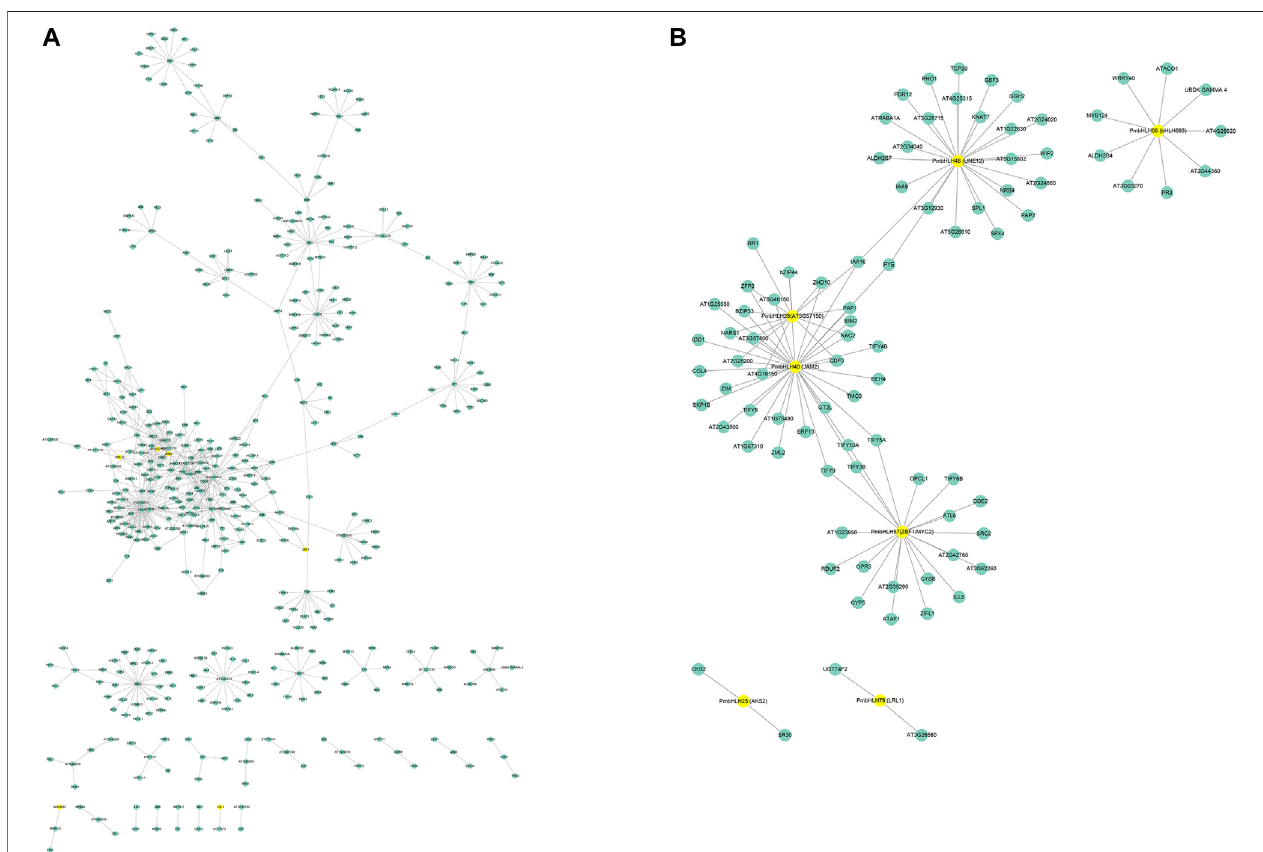
FIGURE 7 | The interaction network for bHLHs in P. mume based on orthologs in Arabidopsis . (A) The whole interaction network for PmbHLHs. (B) Protein interaction network of seven candidate PmbHLHs. Yellow circles represent PmbHLHs and blue circles represent other genes.